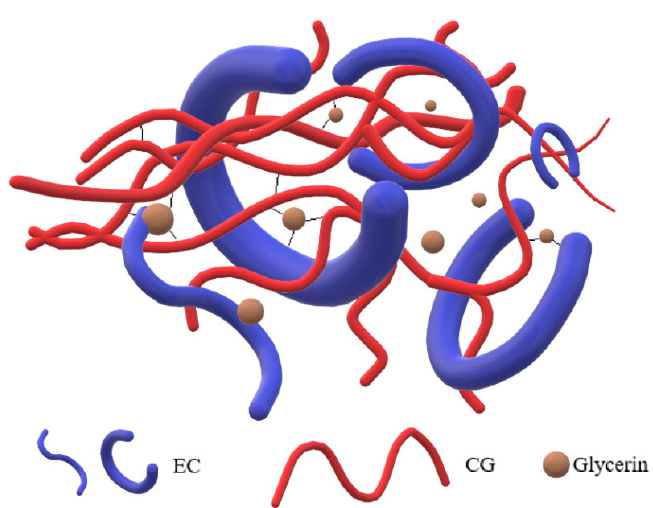
Figure 5. Mechanism diagram of intermolecular action.